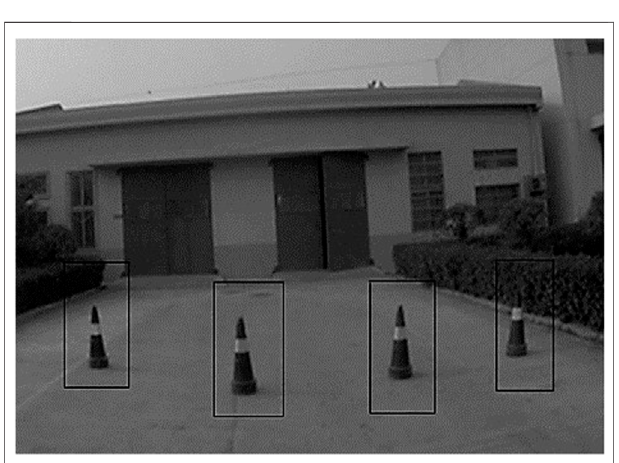
FIGURE 9 | Interested obstacle Areas.